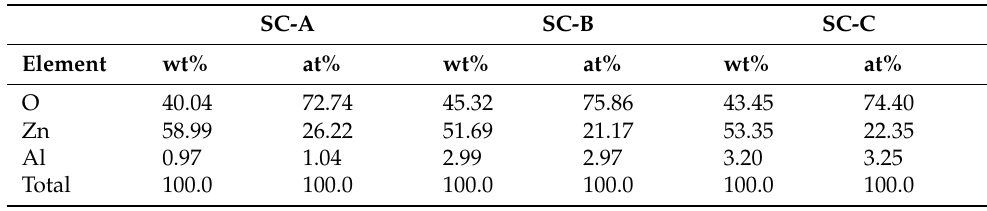
Table 1. Results of the EDA analyses of prepared ZnO seed layers for the three substrates. wt% and at%: percentage by weight and atomic